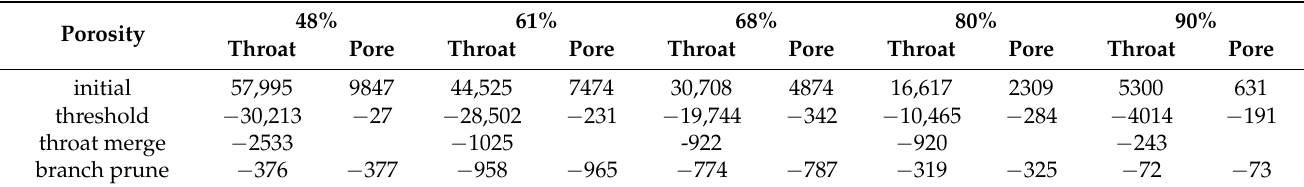
Table 1. Pore network simplification, the number of reduced pore elements (pores and throats) at each step.